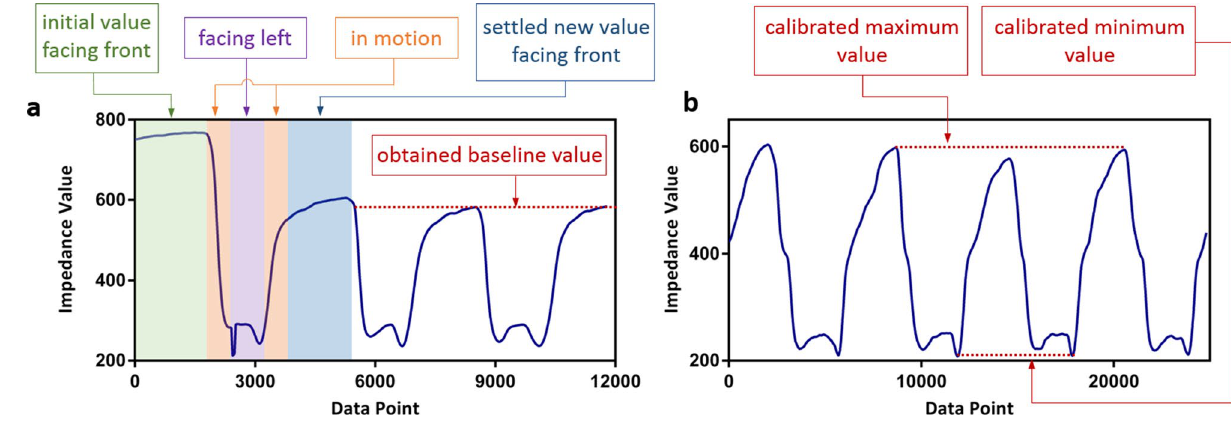
Figure 4. Calibration process ( a ) Calibrate for baseline value ( b ) Calibrate for maximum and minimum